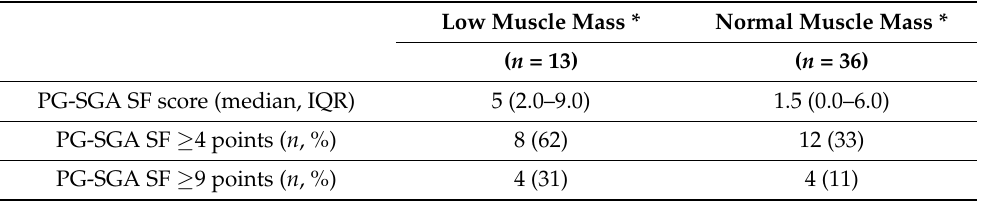
Table 5. Prevalence of malnutrition (PG-SGA SF cut-offs) among patients with low and normal muscle